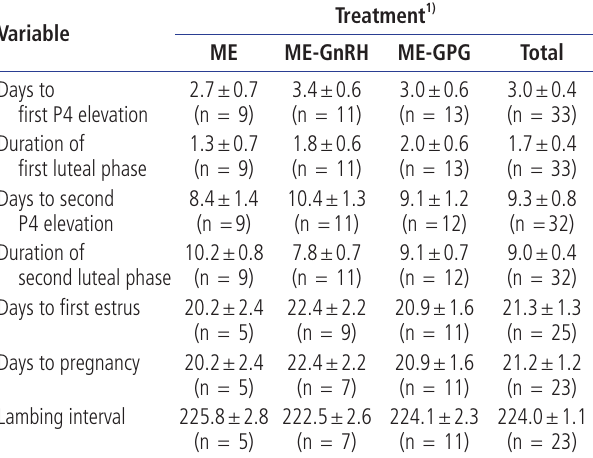
Table 6. Intervals to the first and second elevations of progesterone (P4), duration of the first luteal phase, intervals to estrus and to gestation, and lambing interval for the ewes of each group that initiated their response to treatments with a short